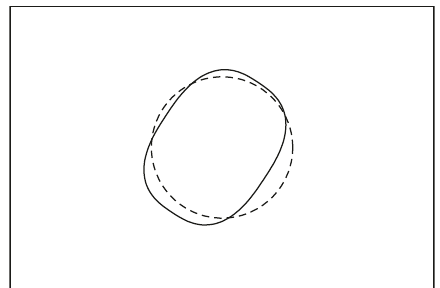
Figure 10: Shapes of Model 1 before and after